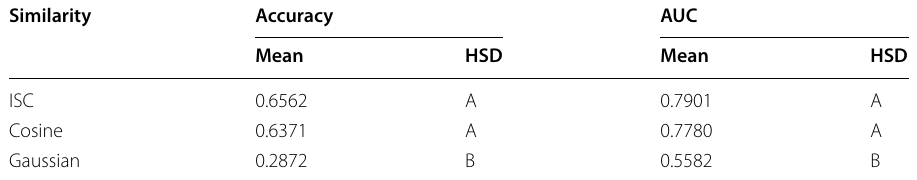
Table 8 Average performance of the similarity measure across all classification learners and data